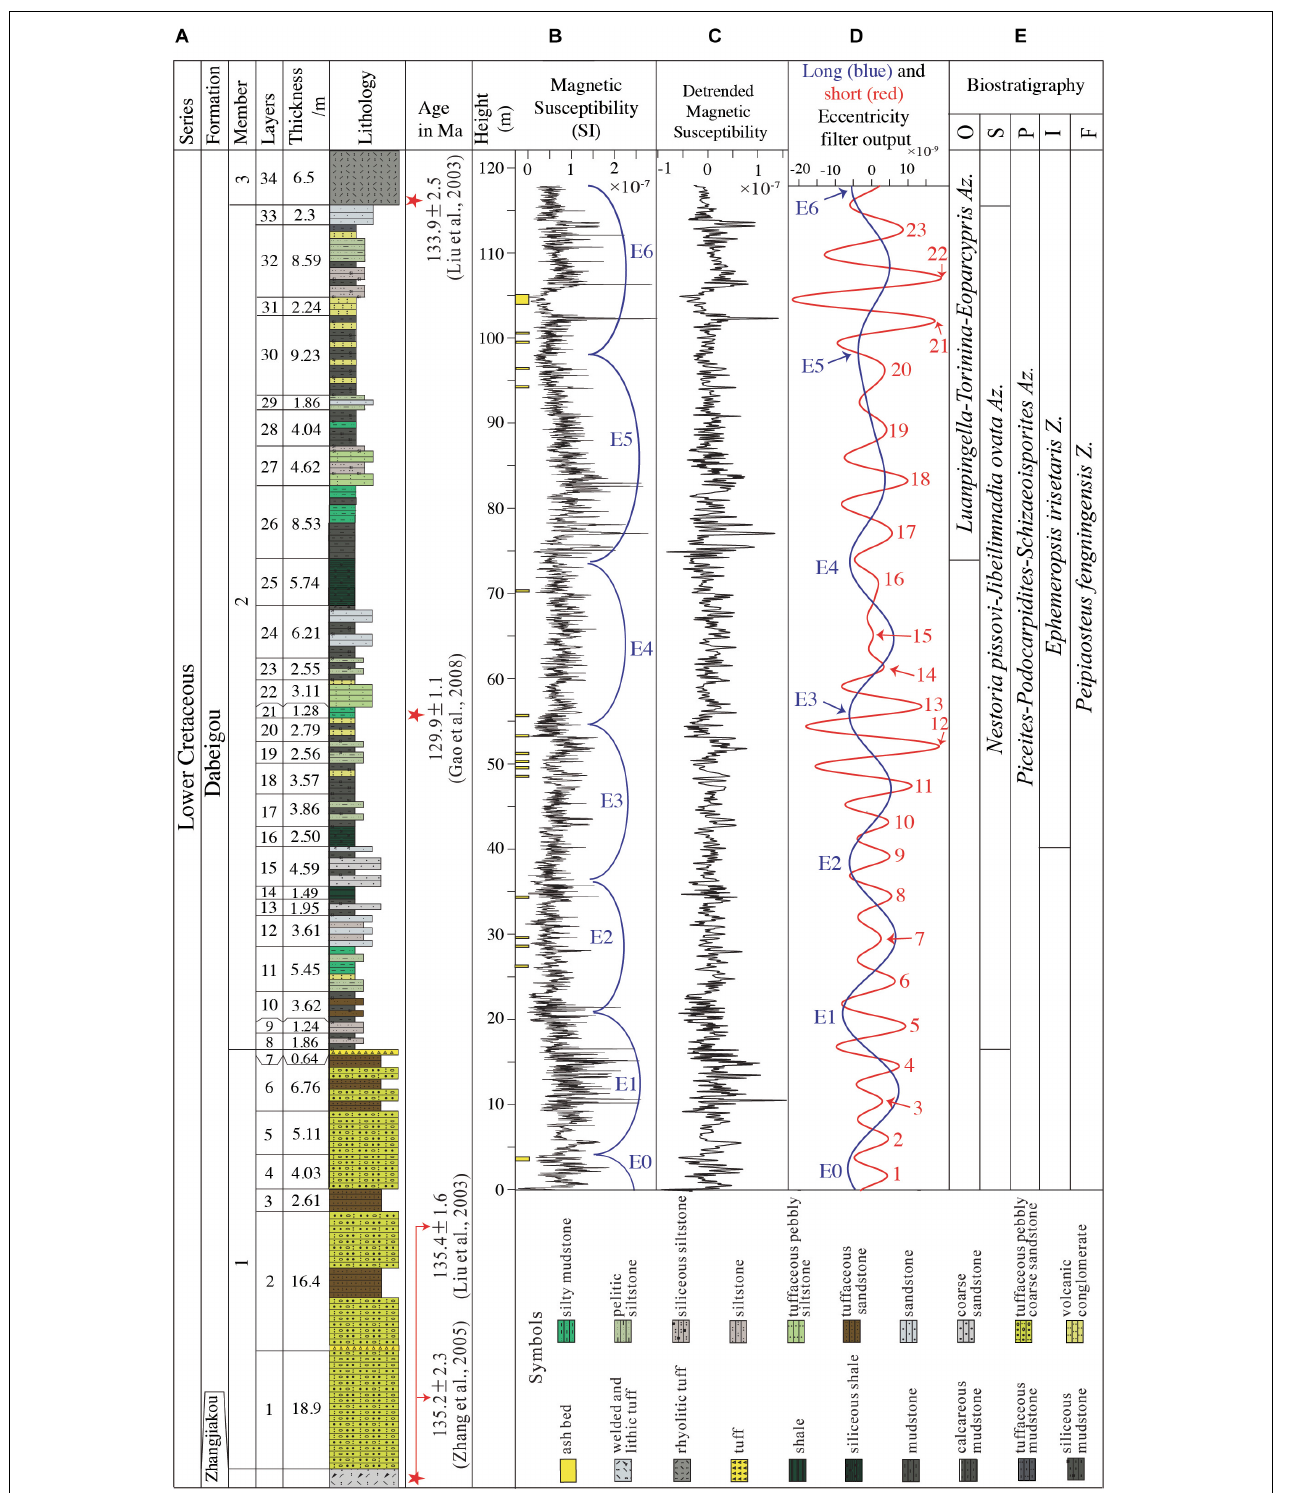
FIGURE 2 | MS series of the DBG section. (A) The detailed measured section with numbered beds and U-Pb ages (modified from Qin et al., 2018). (B) The MS series with interpreted long orbital eccentricity (E0-E6) cycles. (C) Detrended MS series. (D) Long (blue) and short (red) orbital eccentricity Gaussian filter outputs with passbands of 0.053 ± 0.01 and 0.2 ± 0.05 cycles/m, respectively. (E) Biostratigraphy from Qin et al. (2018). O, ostracods; S, spinacaudatans; P, palynotaxa; B, bivalves; I, insects; F, fishes.